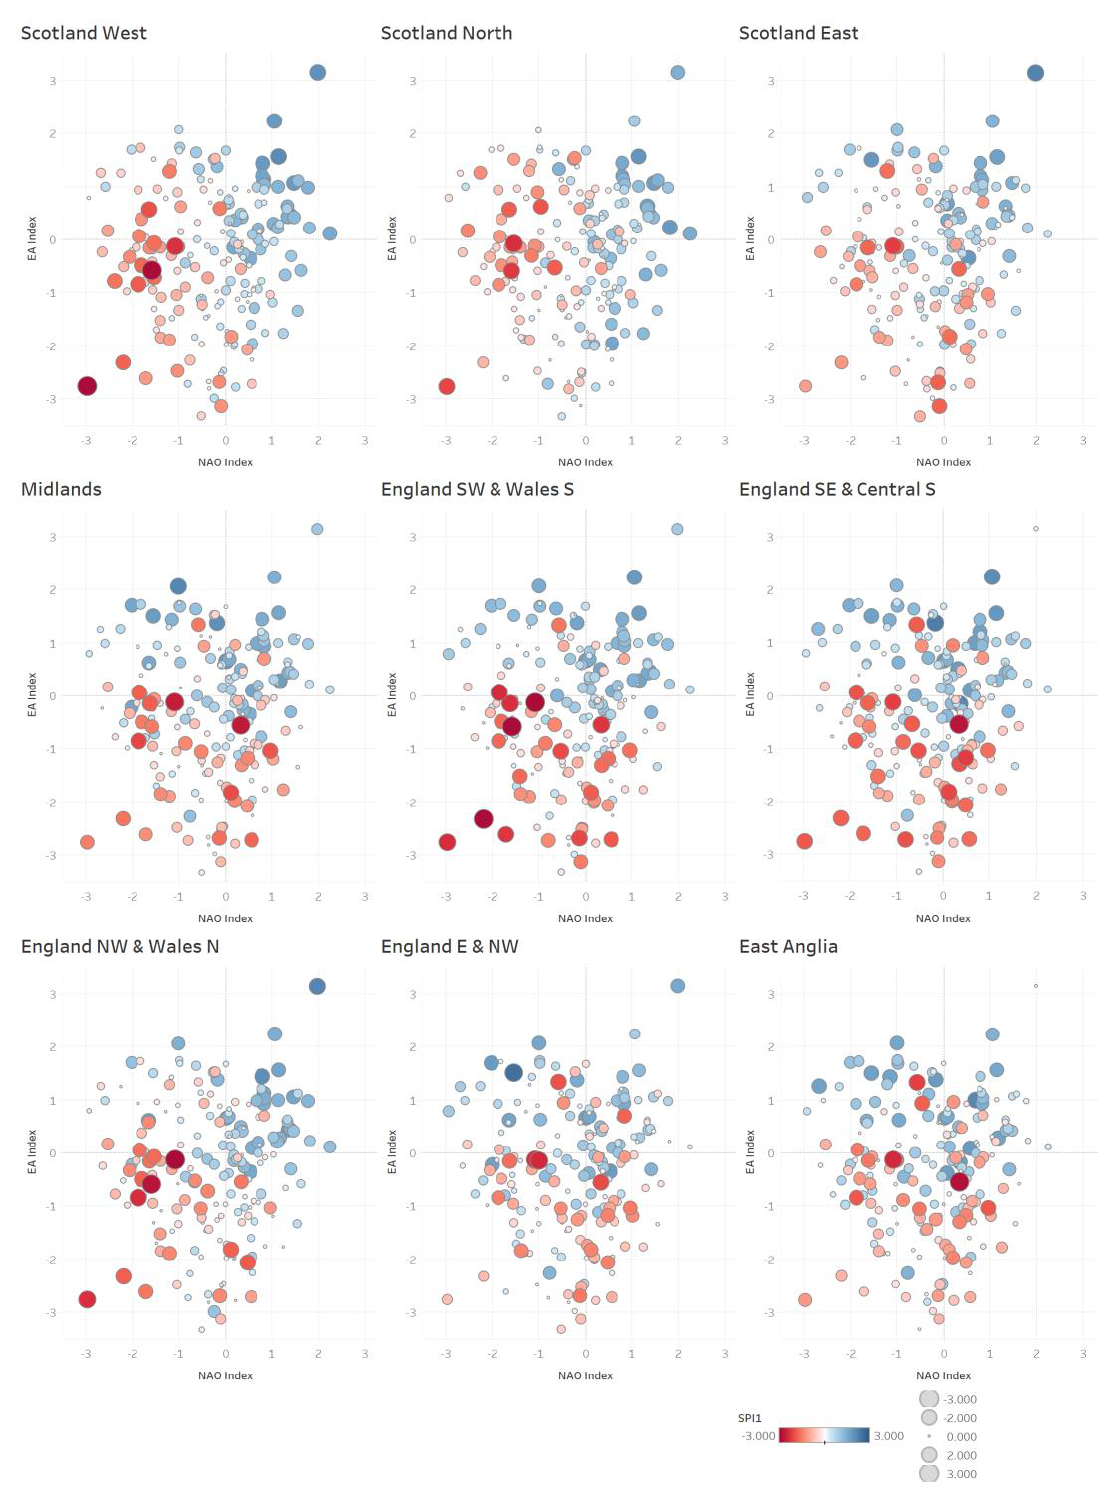
Figure 6. Scatter plots of the NAO and EA indices for the winter (DJF) months with points symbolised based on the Climate District average SPI-1 value. Quadrants with majority red/blue points indicate a drying/wetting tendency associated with that NAO/EA phase combination.